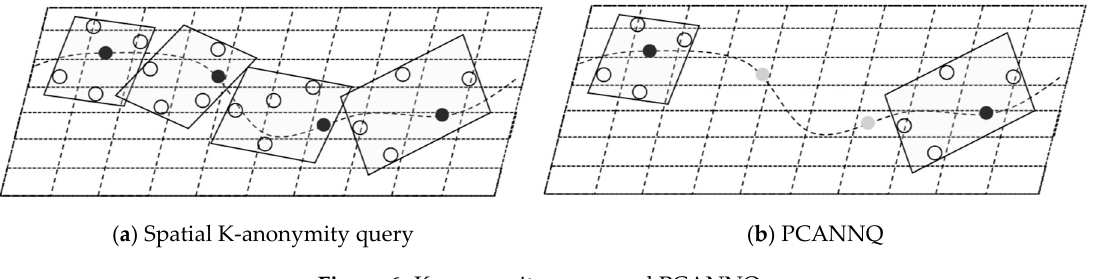
Figure 6. K-anonymity query and PCANNQ.